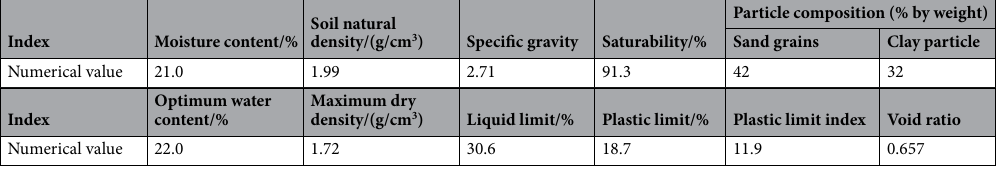
Table 3. Basic physical and mechanical properties of soil.